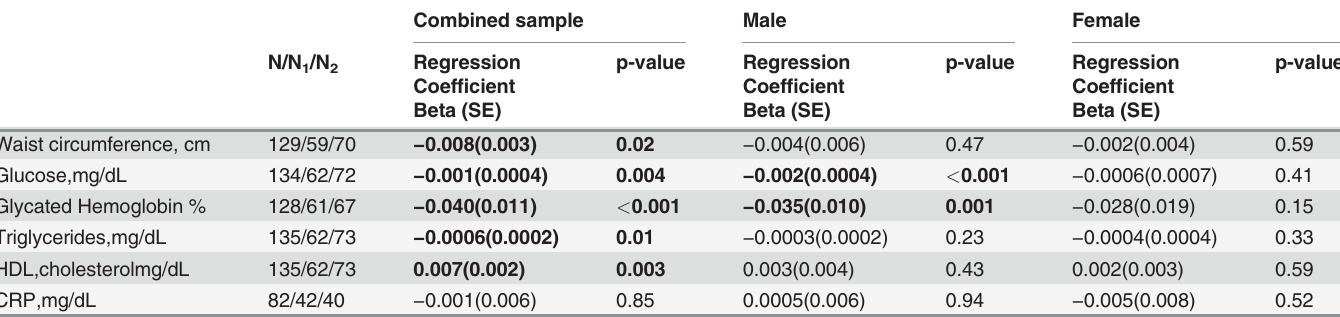
Table 4. Relationship of SAA 1.1R variant ratios with clinical and laboratory characteristics.